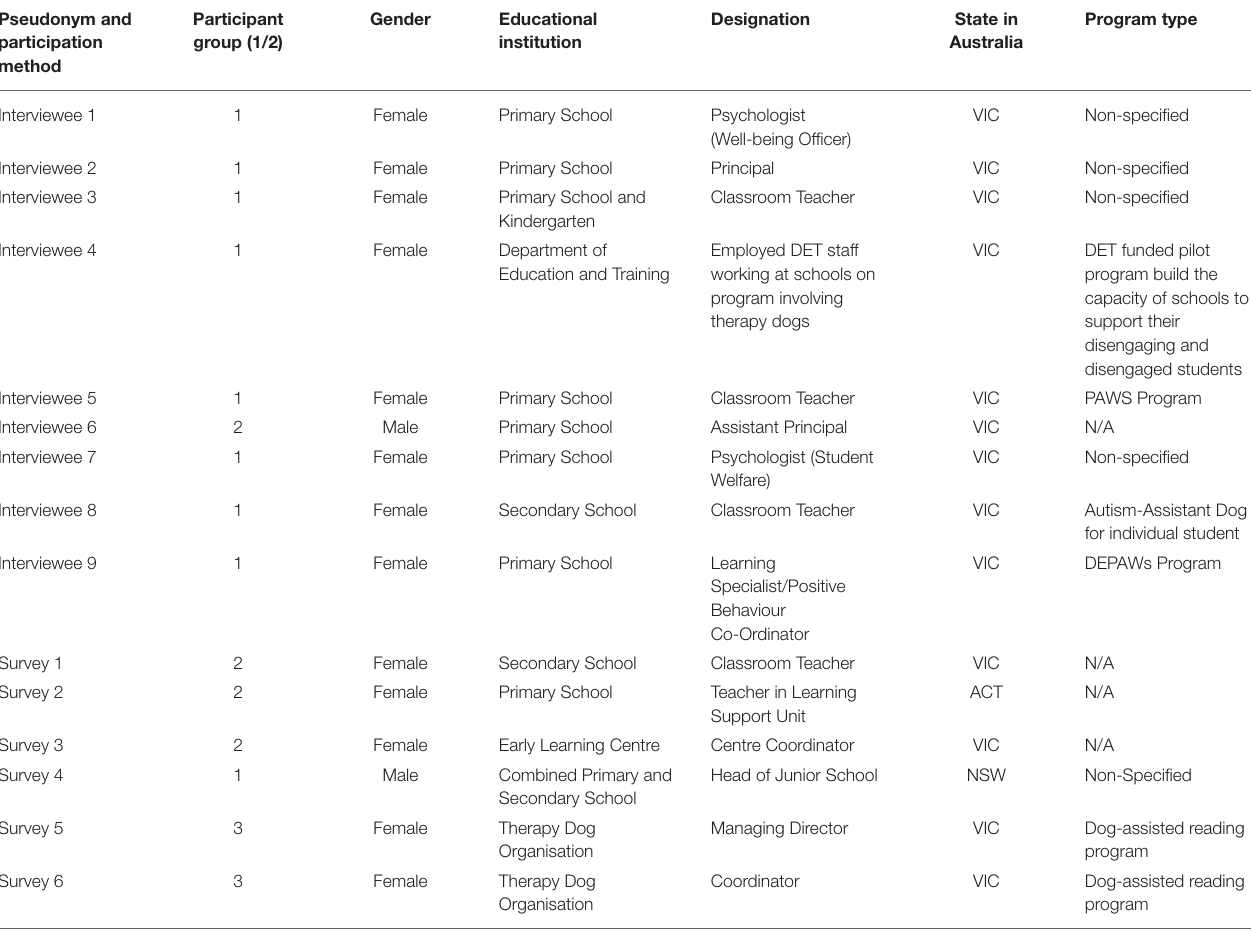
TABLE 1 | Summary of demographic information for